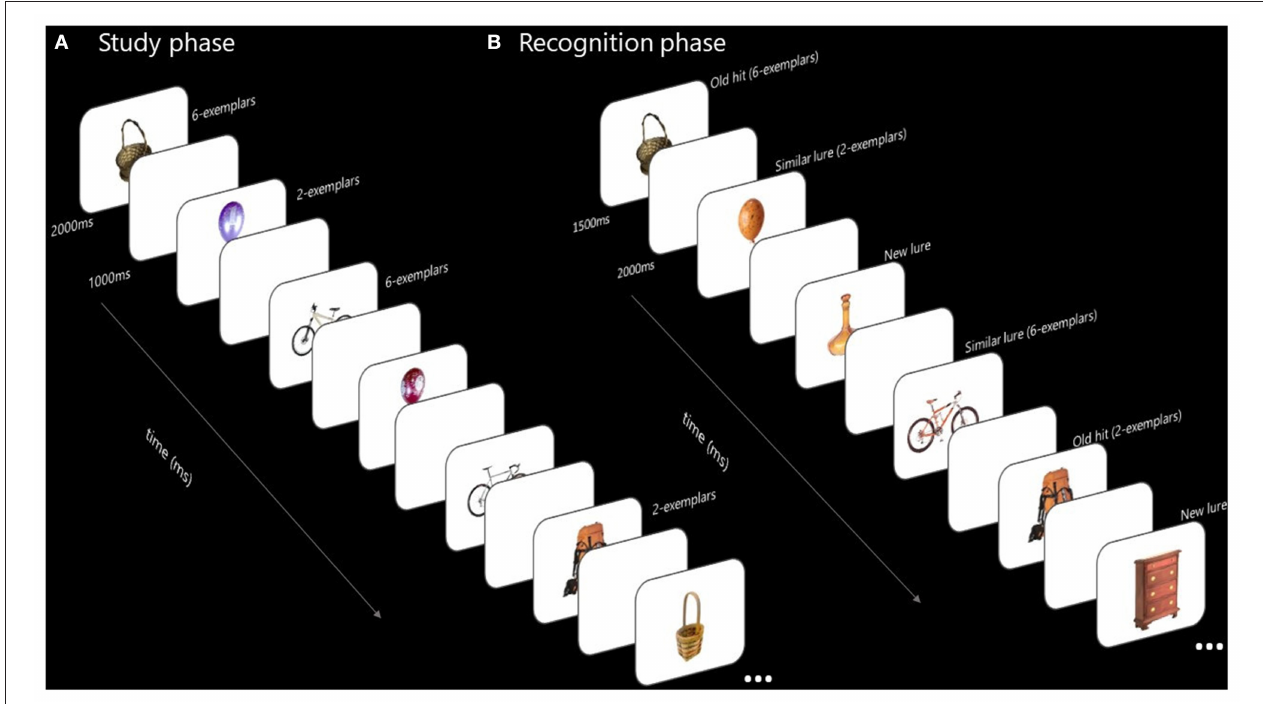
FIGURE 1 | Test structure and examples of the items employed. The 1,440 images of objects from different categories were presented at the study phase. Each image was presented for 1,500ms, followed by a 1,000ms duration white screen. The number of images presented for each category was manipulated to 2 or 6 items. Twenty minutes (in group 1) or 24h (in group 2) after the study phase, discrimination phase was tested. The 540 images of objects from different conditions (old, similar, or new) were presented for 1,500ms, followed by a 2,000ms duration white screen. Participants had to indicate if each of the stimulus presented: had been previously seen in the study phase (old), were a new image of an object not previously presented but from a category previously seen in the study phase (similar) or were an image of a new object from a new category (new). (A) Study phase. (B) Recognition